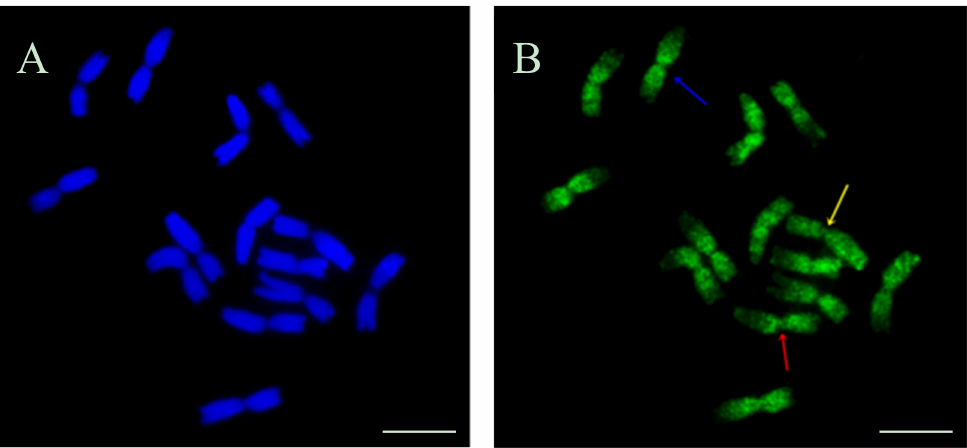
Figure 3. Different replication patterns of the barley chromosome within one metaphase cell. Replication signals were observed in the proximal and interstitial regions of the chromosome (blue arrow), in one entire chromosome arm, and in the proximal region of the second arm (red arrow) and in whole chromosomes (yellow arrow). ( A ) DAPI staining. ( B ) results of 5-ethynyl-2 (cid:48) -deoxyuridine (EdU) incorporation and detection with Alexa Fluor 488 azide. Bars represent 10 µ